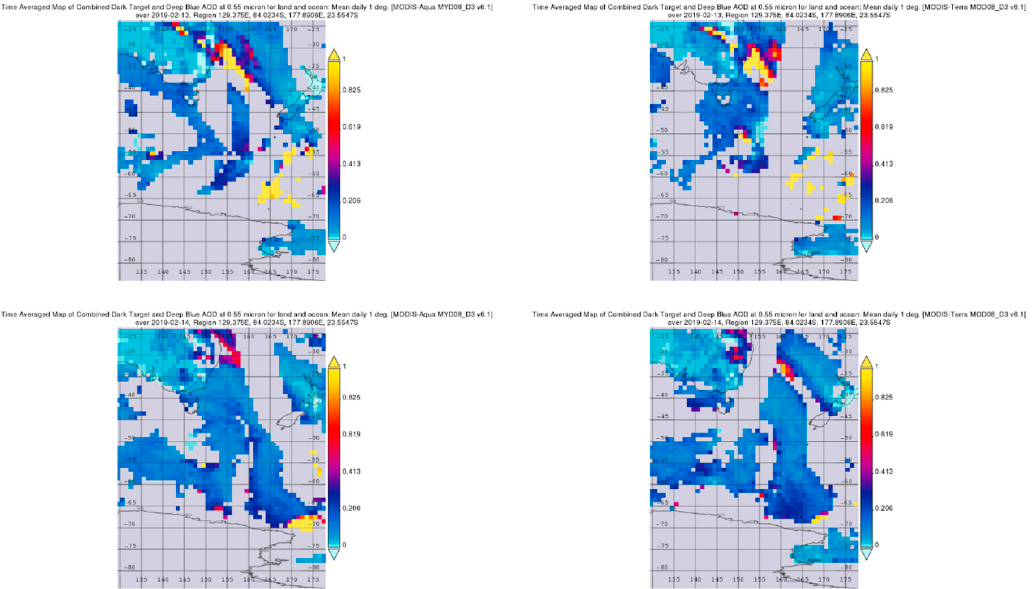
Figure A3. ( a ) Aqua MYD08-E3 maximum and mean of daily mean on land for the period from 10 to 13 February 2019 and ( b ) Aqua MYD08-E3 Combined Dark Target (ocean) and Deep Blue (land) maximum and mean of daily mean for the period from 10 to 17 February 2019.